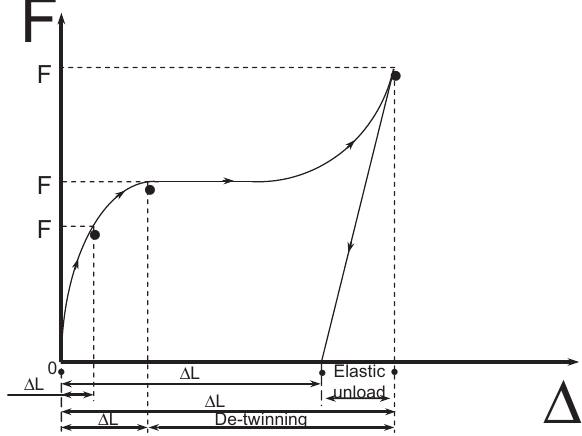
Figure 12 Layer structure of macroscopic shape memory alloy model.